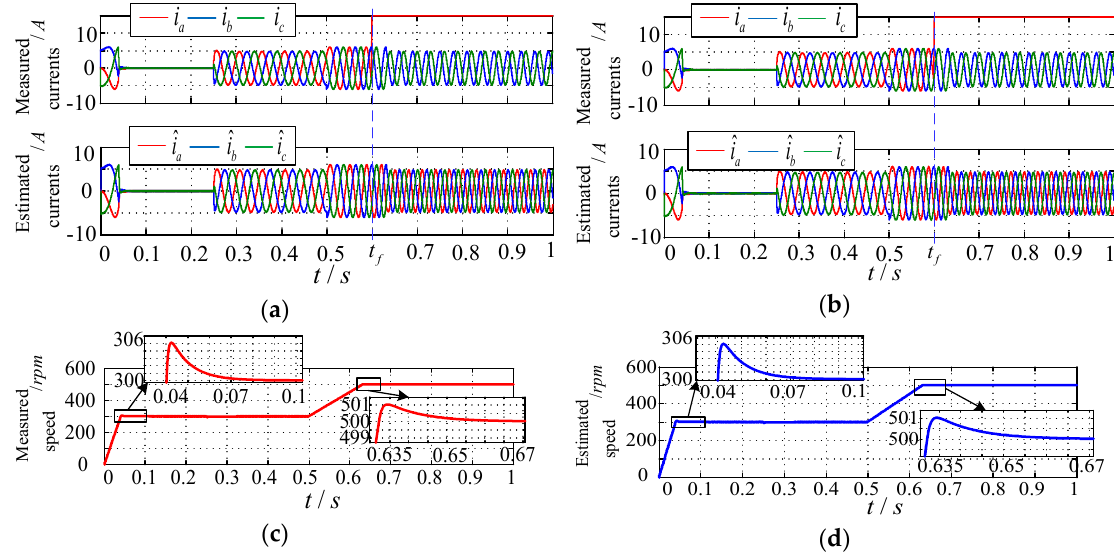
Figure 9. The observed signal output waveforms of two types of system when the a -phase current sensor is stuck. ( a ) The measured current i abc and estimated current ˆ i abc based on composite sliding mode observer; ( b ) The measured current i abc and estimated current ˆ i abc based on traditional sliding mode observer (Multi-observer system); ( c ) The estimated speed ˆ ω based on composite sliding mode observer; ( d ) The estimated speed ˆ ω based on Luenberger observer (multi-observer system).